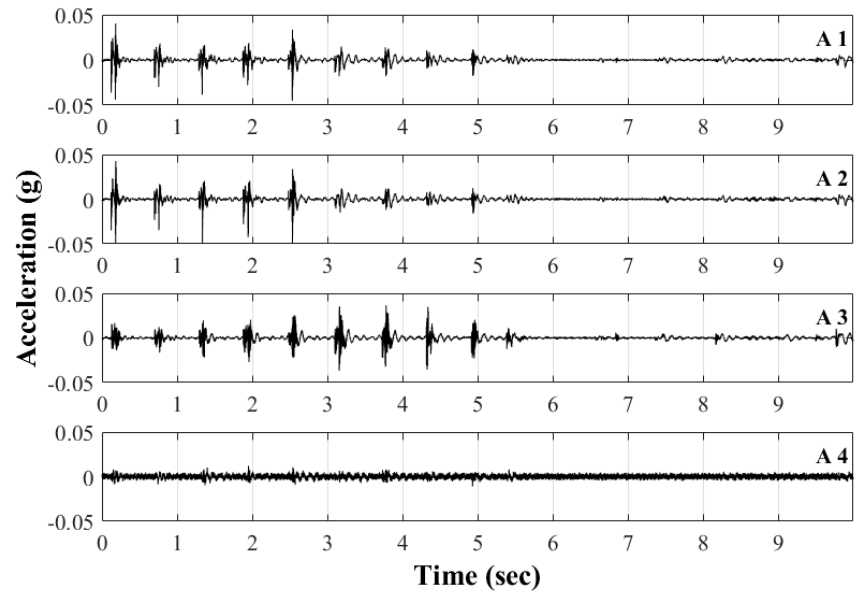
Figure 8. Accelerometers time records triggered by footfall.